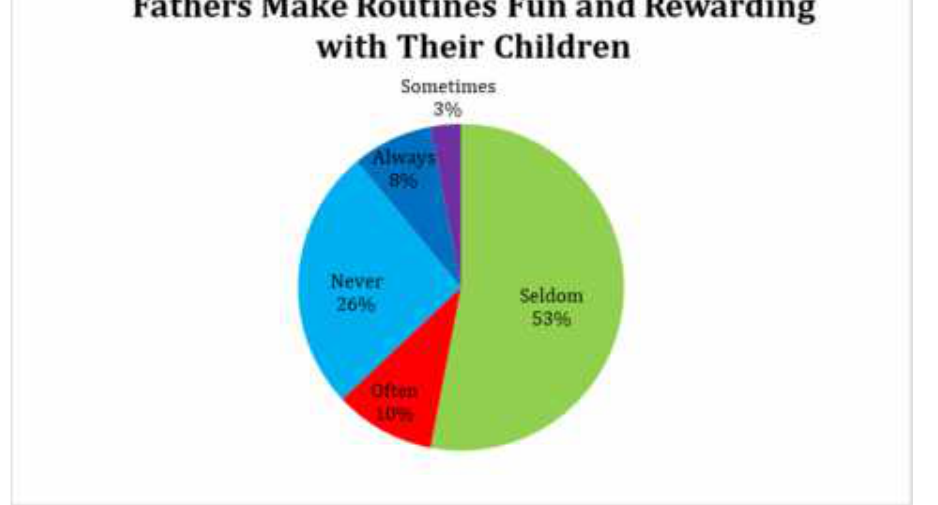
Fig 4 Fathers Make Routines Fun and Rewarding with Their